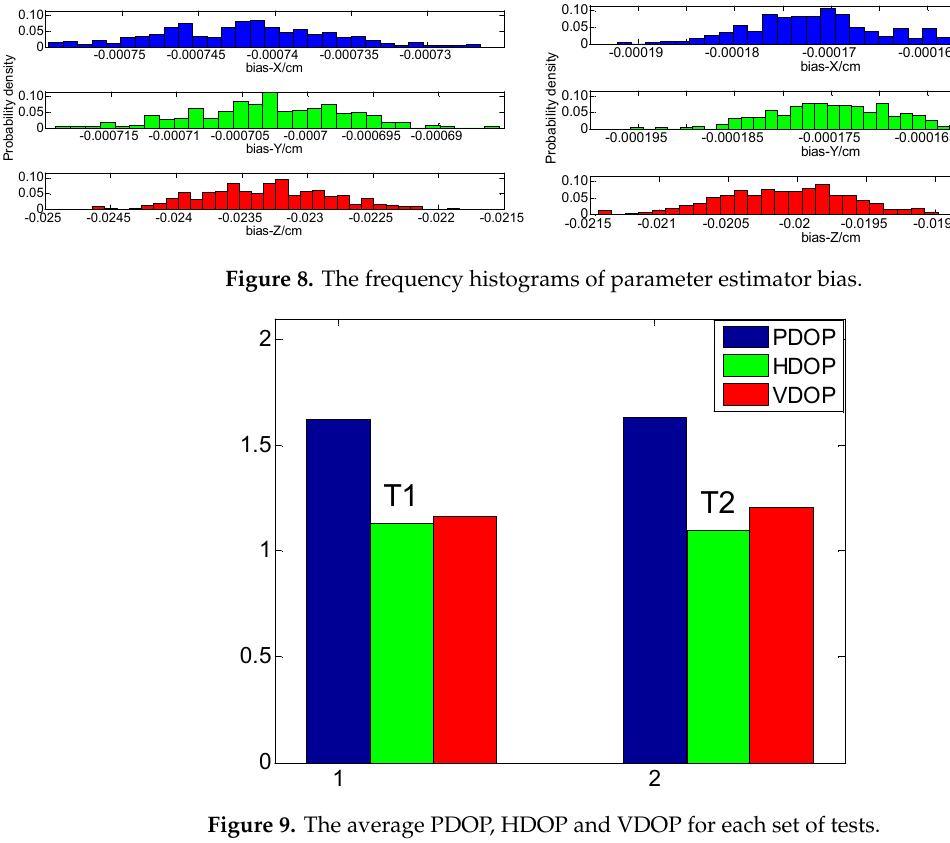
Figure 9. The average PDOP, HDOP and VDOP for each set of tests.